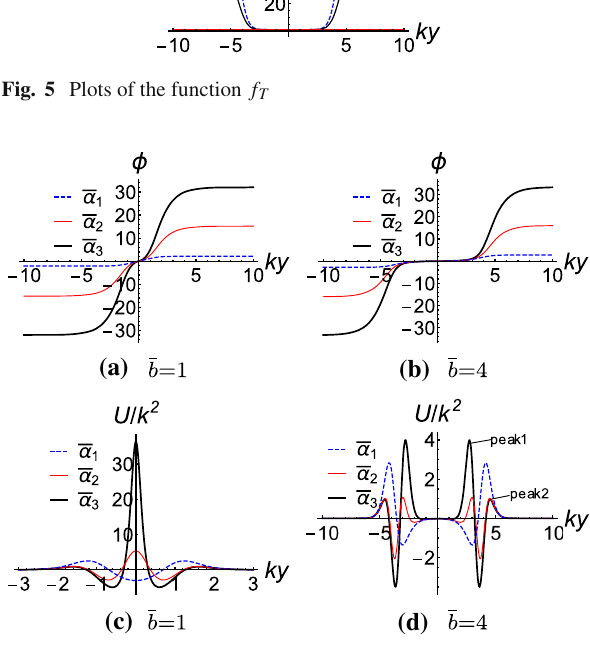
Fig. 5 Plots of the function f T